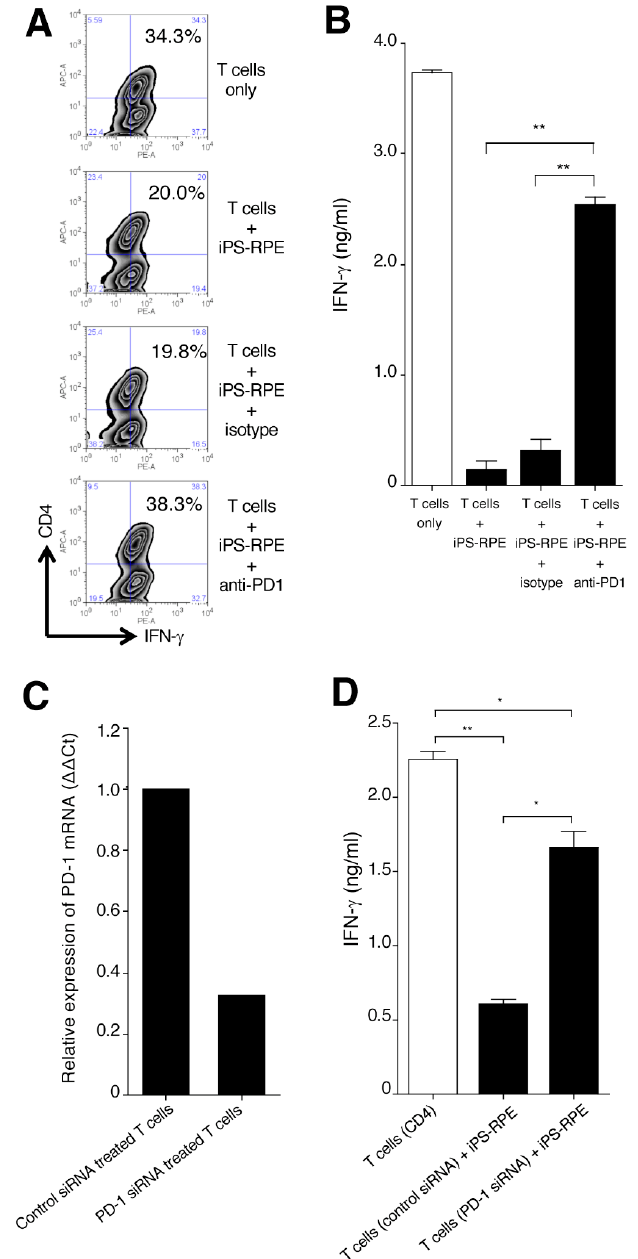
Figure 5. Effect of B7-H1 produced by human iPS-RPE cells on the suppression of T-cell activation. CD4 + Th1 cells from a VKH uveitis patient were cocultured with iPS-RPE cells in the presence of anti-PD-1 blocking antibody or isotype control and evaluated by IFN- γ staining ( A : FACS) or IFN- γ production ( B : ELISA) by the T cells. T cells were cocultured with to 5 × 10 5 (T cell:RPE ratio = 2:1) iPS- RPE cells. ( A ) In FACS, numbers in the histograms indicate the percentage of cells double-positive for CD4 and IFN- γ . ( B ) Data are the means ± SEM of 3 ELISA determinations. ** p < 0.005, as compared to two groups. ( C ) PD-1-siRNA-transfected CD4 + Th1 cells from a VKH patient were harvested on day 3 and examined for the expression of PD-1 mRNA by qRT-PCR. Control-siRNA-transfected T cells were also analyzed. Results indicate relative expression ( ΔΔ Ct). ( D ) PD-1-siRNA-transfected CD4 + T cells (or control-siRNA-transfected cells) were cocultured with iPS-RPE cells and evaluated by IFN- γ production by the uveitis T cells (T cell:RPE ratio = 2:1). Data are the means ± SEM of 3